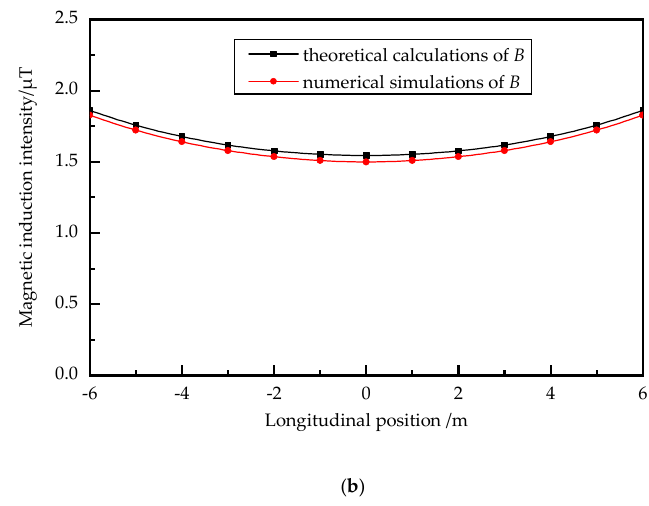
Figure 6. Variations of magnetic induction intensity along three test lines under N–S connection condition. ( a ) Variations along two radial test lines (at longitudinal positions z = 0 m and z = 6 m); ( b ) variations along the longitudinal test line (at radial distance ρ = 2 m).